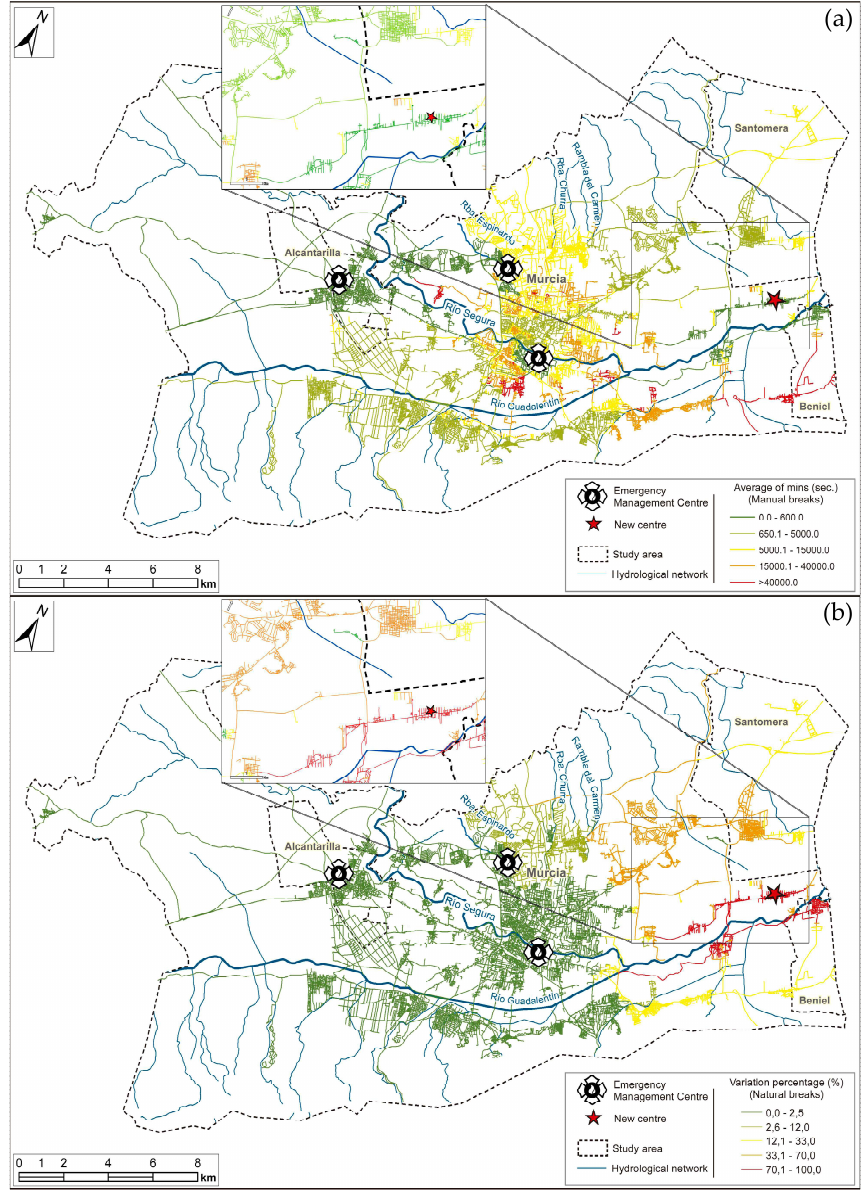
Figure 8. ( a ) Maps of future vulnerability scenarios; ( b ) Percentage of